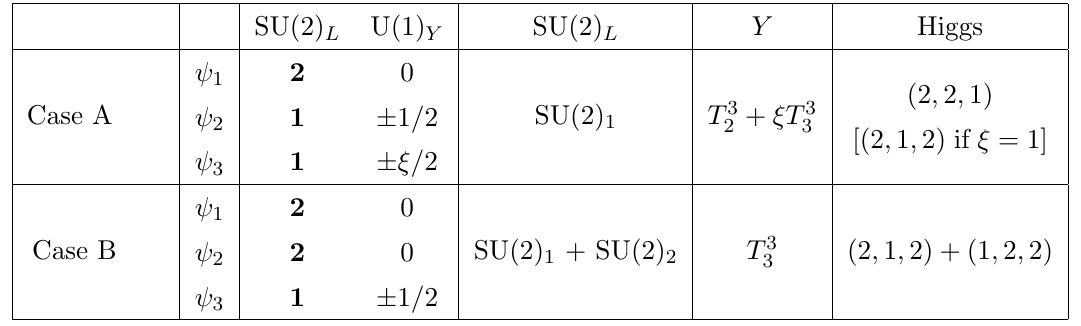
Table 1 . Quantum number assignments for the underlying techni-fermions. T 3 generators of each SU(2) i